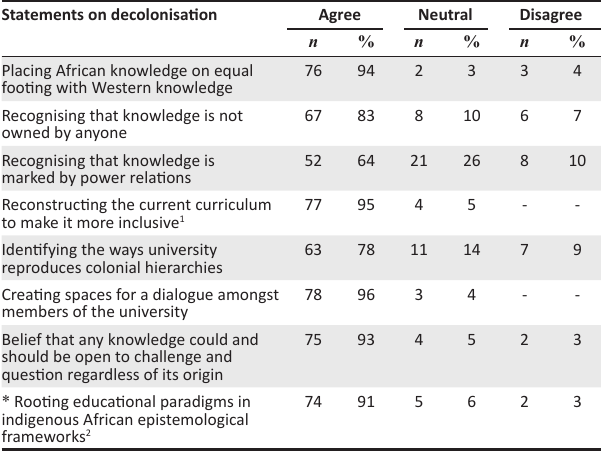
TABLE 2: What decolonisation entails for higher education.